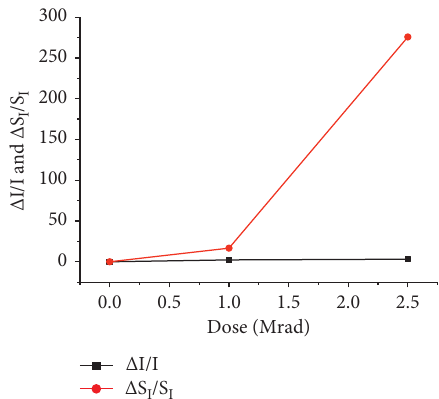
Figure 6: Comparison between variation of current and variation of current noise spectral